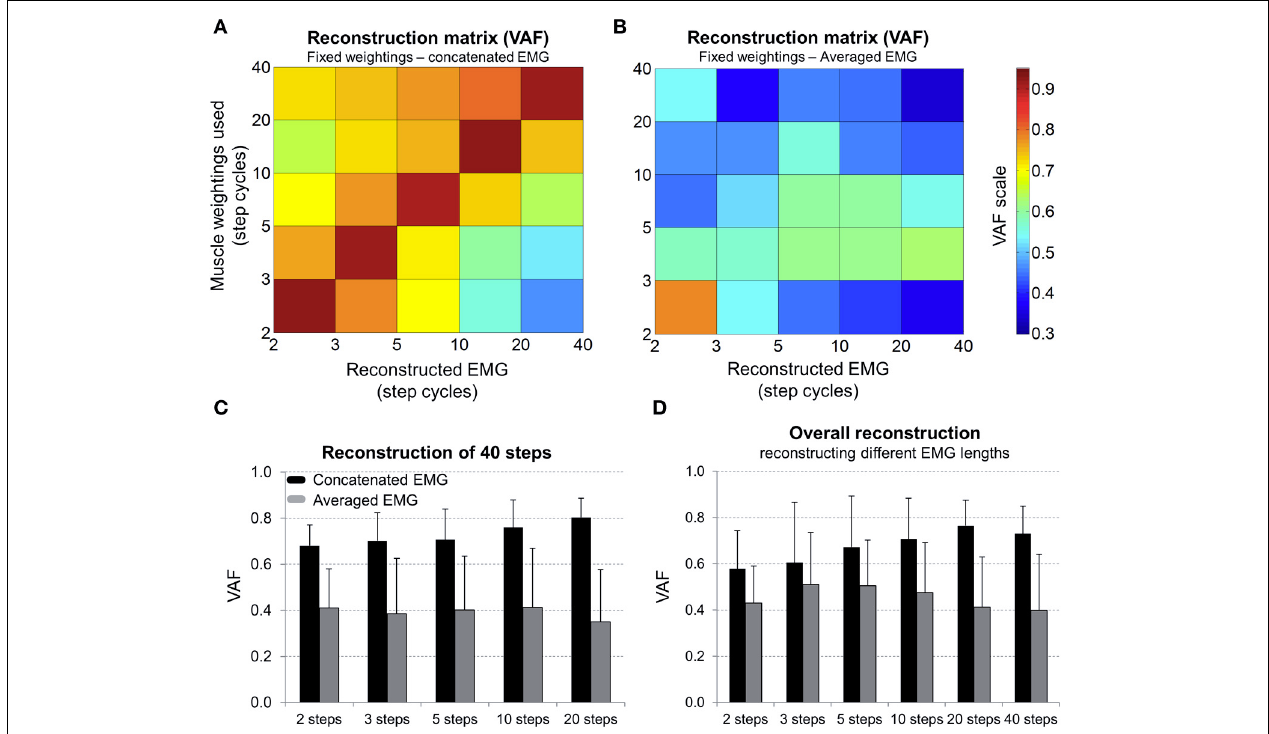
FIGURE 5 | (A) Colormap representing the variability accounted for (VAF) the reconstruction of surface EMG weightings by combining fixed muscle weightings from a given number of step cycles to the activation signals of a given number of step cycles. (B) Mean (SD) VAF of reconstructing EMG from 40 concatenated step cycles by using muscle weightings from the concatenation of 2–20 steps. (C) Mean (SD) VAF of reconstructing an entire